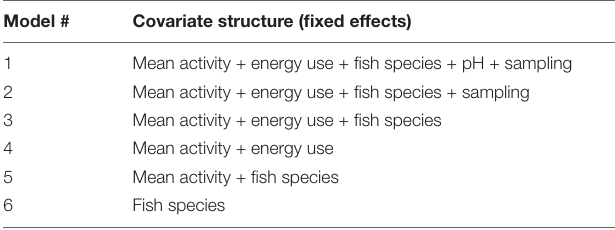
TABLE 3 | Covariate structures of the candidate Gamma GLMM with a log link